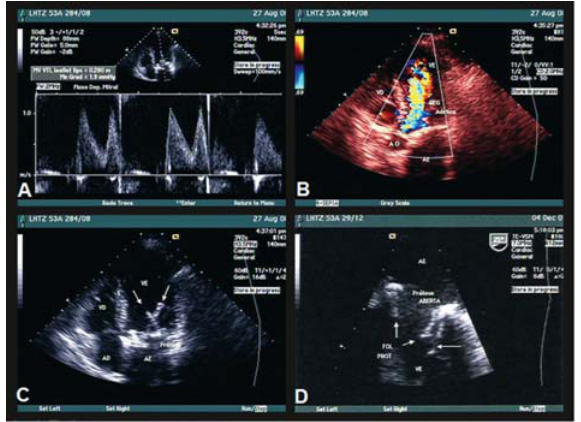
Fig. 3 – (A) Prótese mitral com gradiente normal; (B) regurgitação valvar aórtica leve; C) cruzamento dos enxertos subvalvar (D) abertura normal da prótese